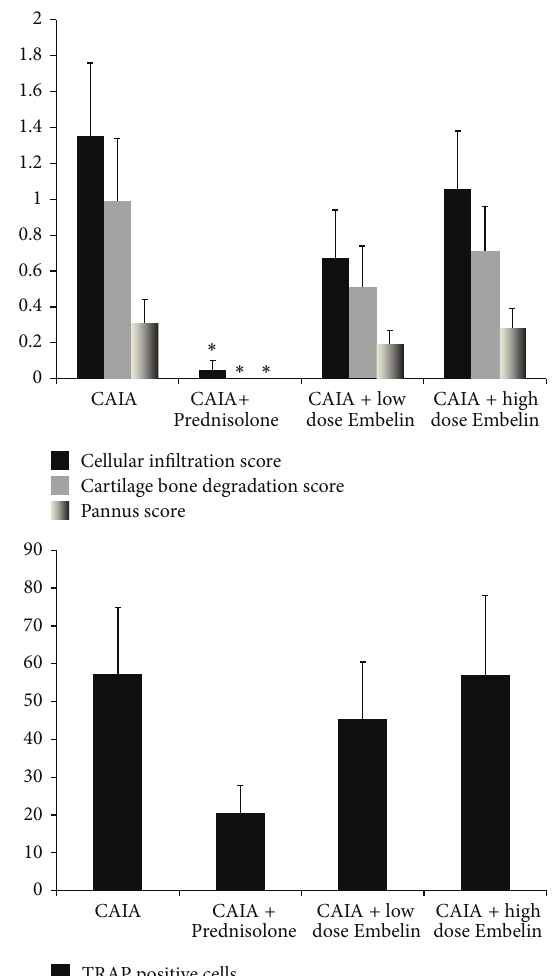
Figure 3: Histological and TRAP scores (obtained using scores as described in Section 2) on paw tissues at day 10. Bars represent mean ± SEM. ∗ 𝑃 < 0.05 .